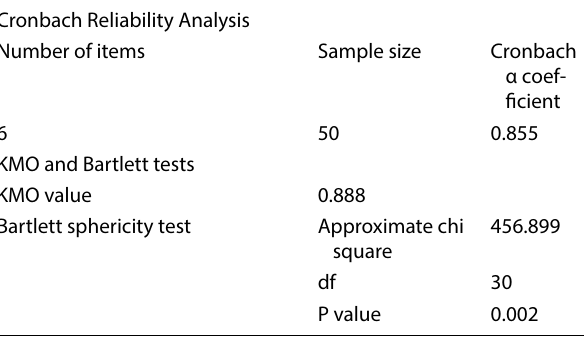
Fig. 4 Analysis of students’ interest in learning and accept-